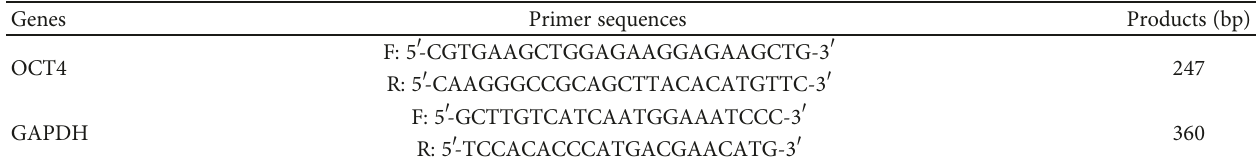
Table 1: Primer sequences used in the